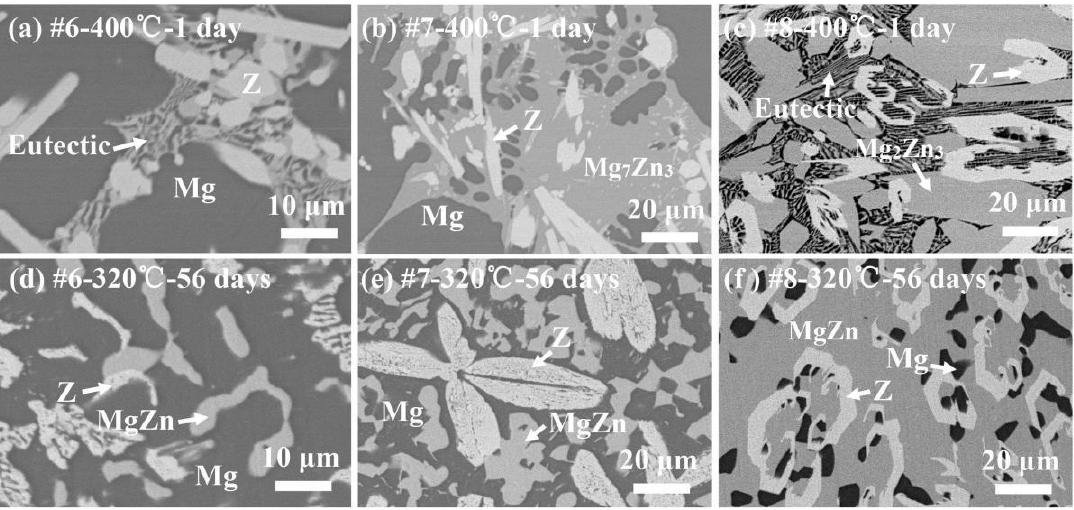
Figure 7. The BSE images of alloys #6 – #8 annealed at ( a – c ) 400 °C for 1 day and ( d – f ) 320 °C for 56 days.